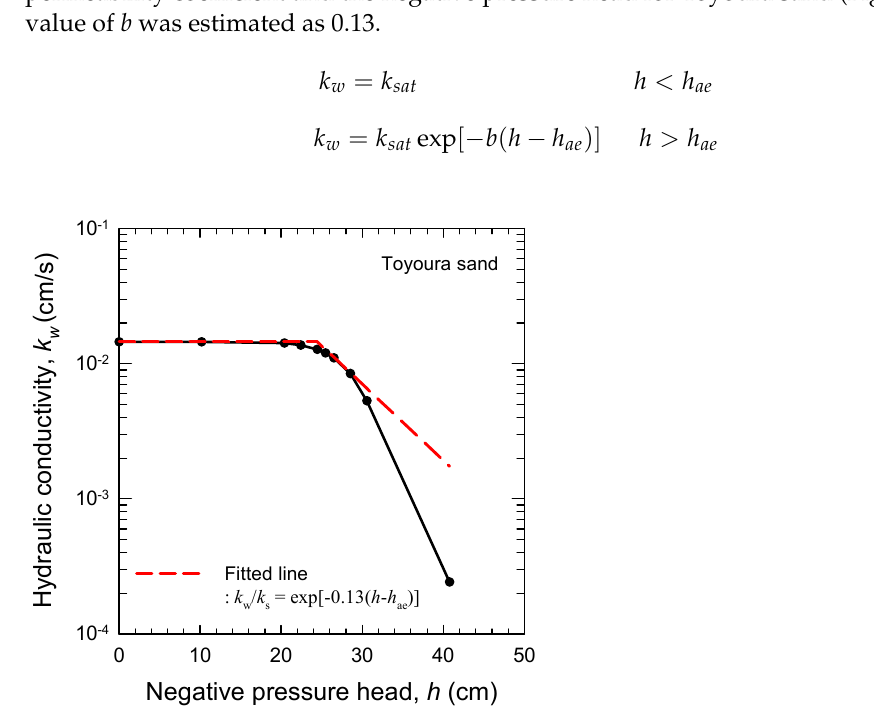
Figure 10. Exponential approximation of the relationship between the unsaturated permeability coefficient and the negative pressure head for Toyoura sand.